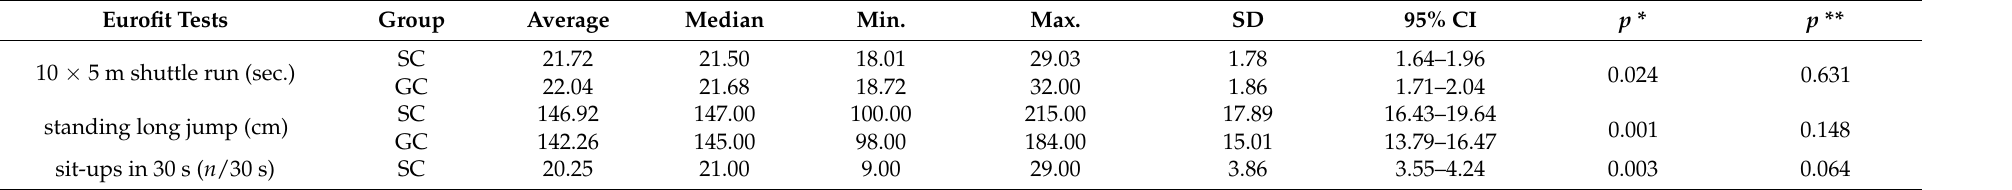
Table 4. Averaged fitness tests results from the initial and final measurement